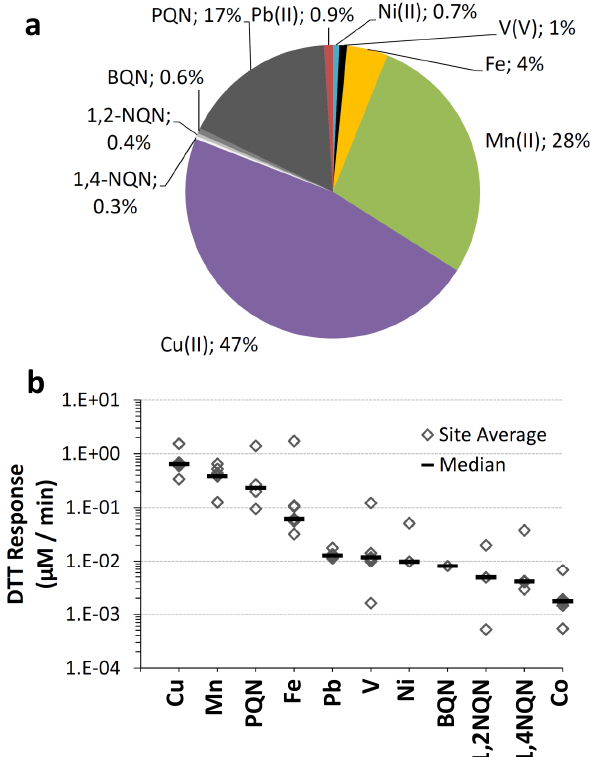
Fig. 5. (a) Calculated contributions of soluble metals and quinones to DTT loss in a hypothetical typical PM 2 . 5 sample. The aerosol concentration for each metal and quinone, and the corresponding rate of DTT loss from each component, was estimated based on median concentrations in ambient PM 2 . 5 (see Sect. S2 in the Sup- plement for more details). The total rate of DTT loss in this hypo- thetical sample is 1.4µMmin − 1 . (b) Calculated rates of DTT loss from individual species in hypothetical extracts of PM 2 . 5 based on reported particulate concentrations. Each diamond represents the DTT response for the average concentration of DTT-active species from a given site. Each horizontal line is the response from the me- dian concentration of the site averages. Using the median values for all of the DTT-active species gives the DTT reactivity distribution shown in panel (a).